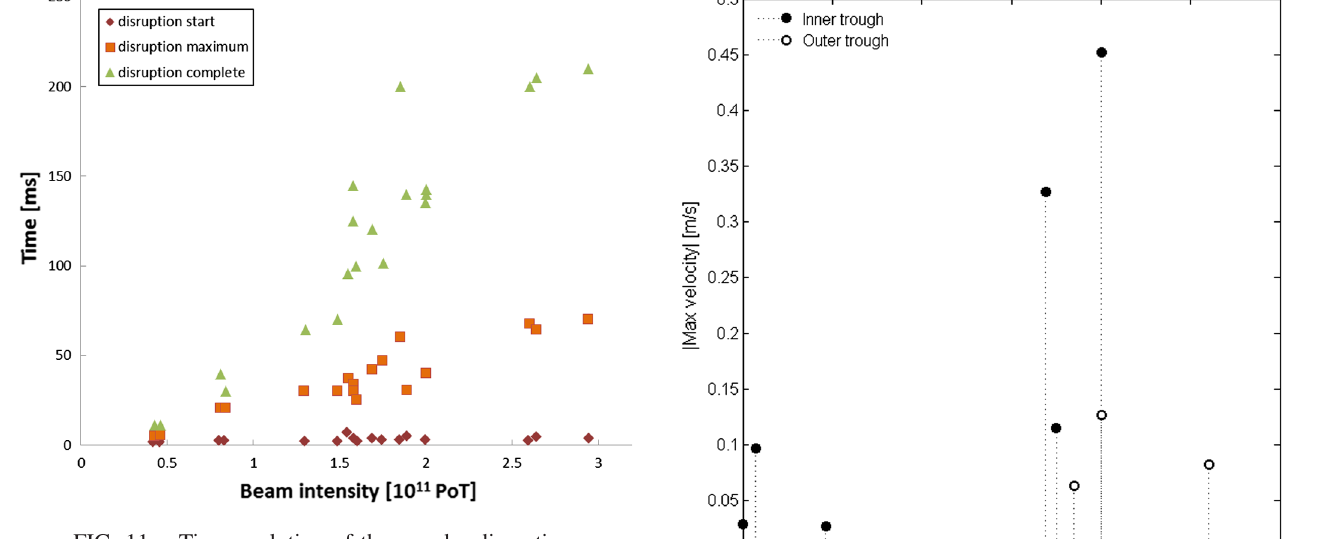
intensity.FIG. 11. Time evolution of the powder disruption.